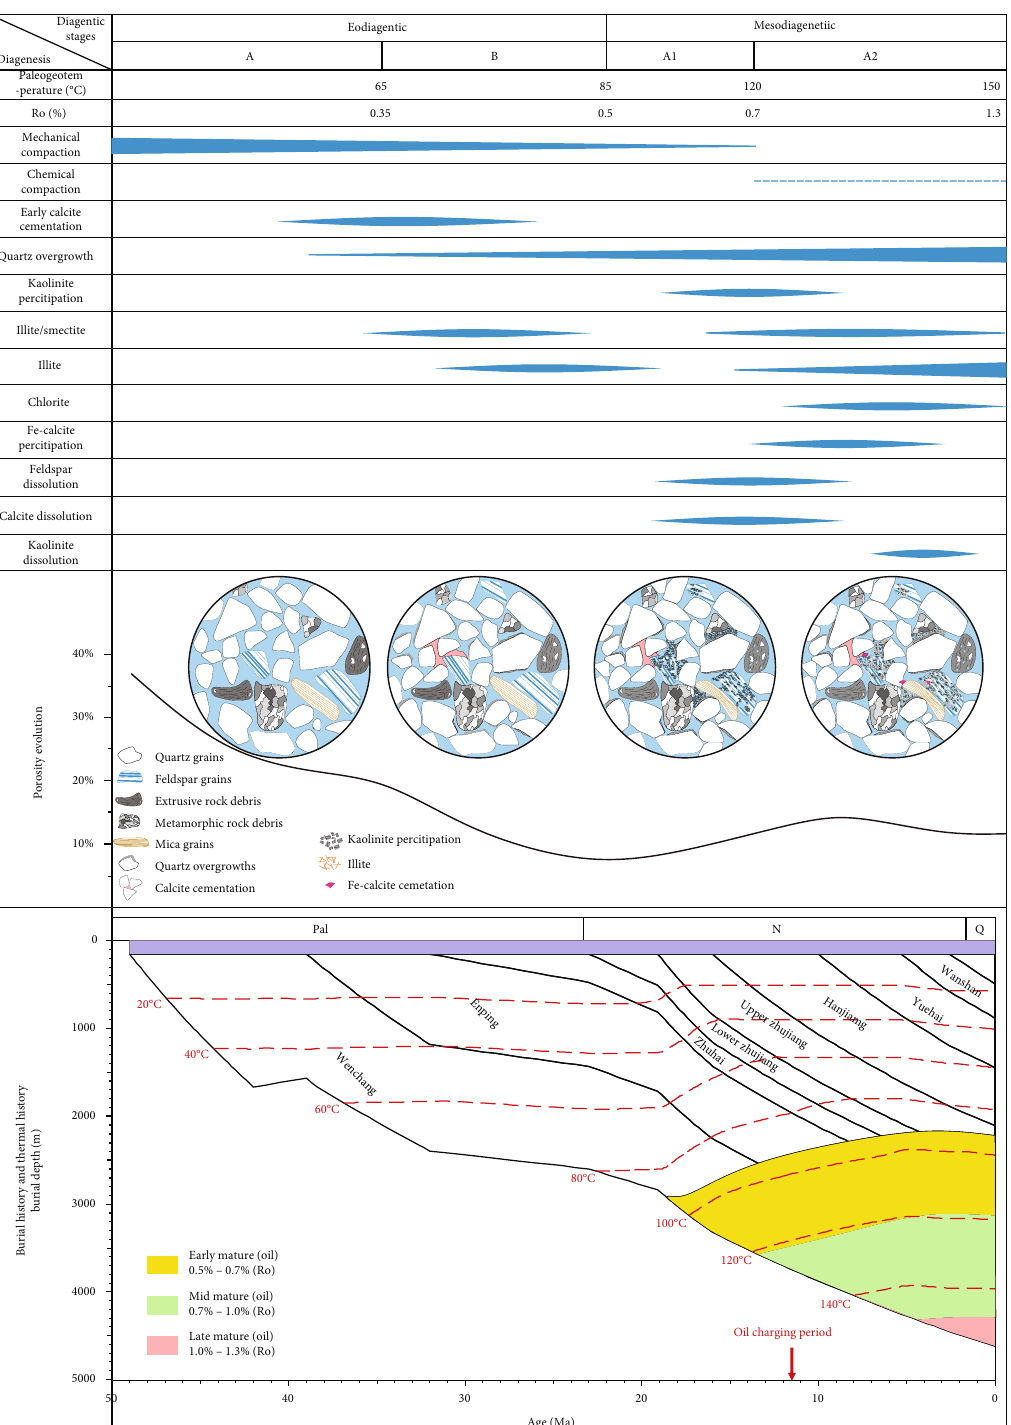
Figure 17: Diagenetic evolution, burial history, and thermal history of E